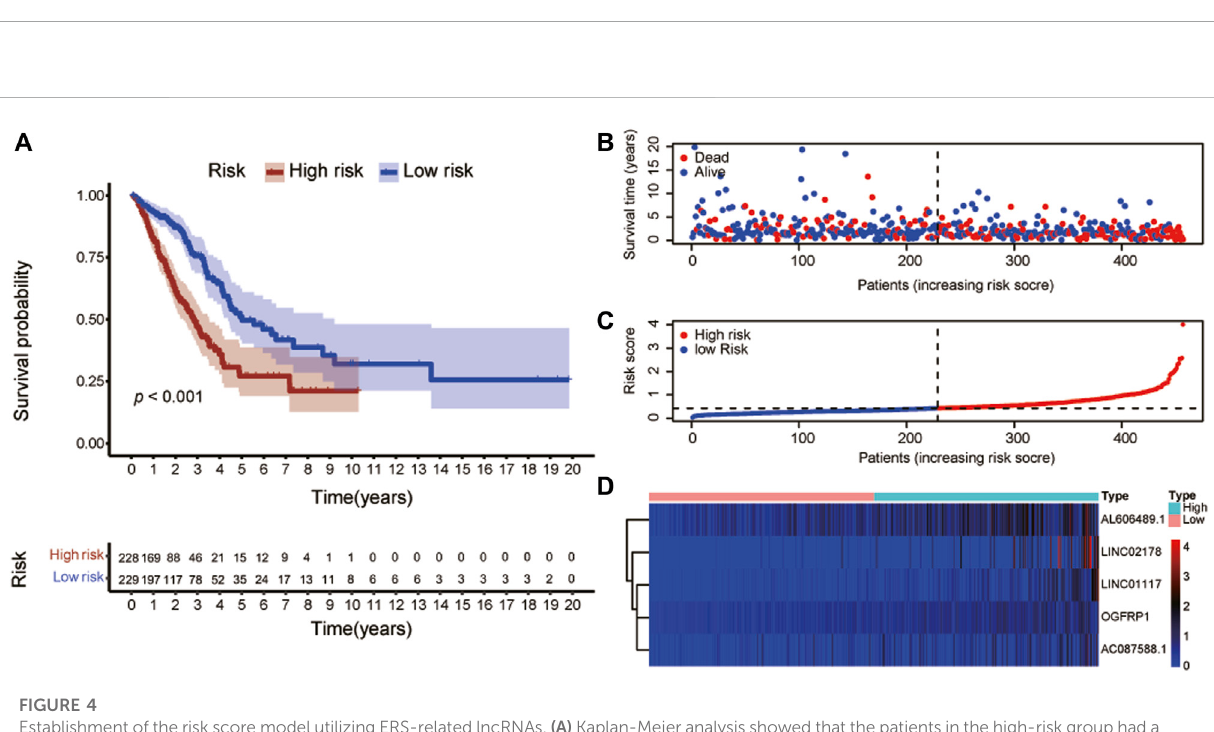
FIGURE 3 Screening ERS-related lncRNAsrelated to prognosis. (A) Based onunivariateCox analysis,11ERS-relatedlncRNAsweresigni fi cantly correlatedwith LUAD patients ’ OS, as shown in the forest plot. (B) LASSO analysis was utilized to fi lter out ERS-related lncRNAs in LUAD patients. (C) The LASSO coef fi cient spectrum for lncRNAs linked to ERS is shown. OS: Overall survival; LUAD: Lung adenocarcinoma; ERS: Endoplasmic reticulum stress; LASSO: Least absolute shrinkage and selection operator.